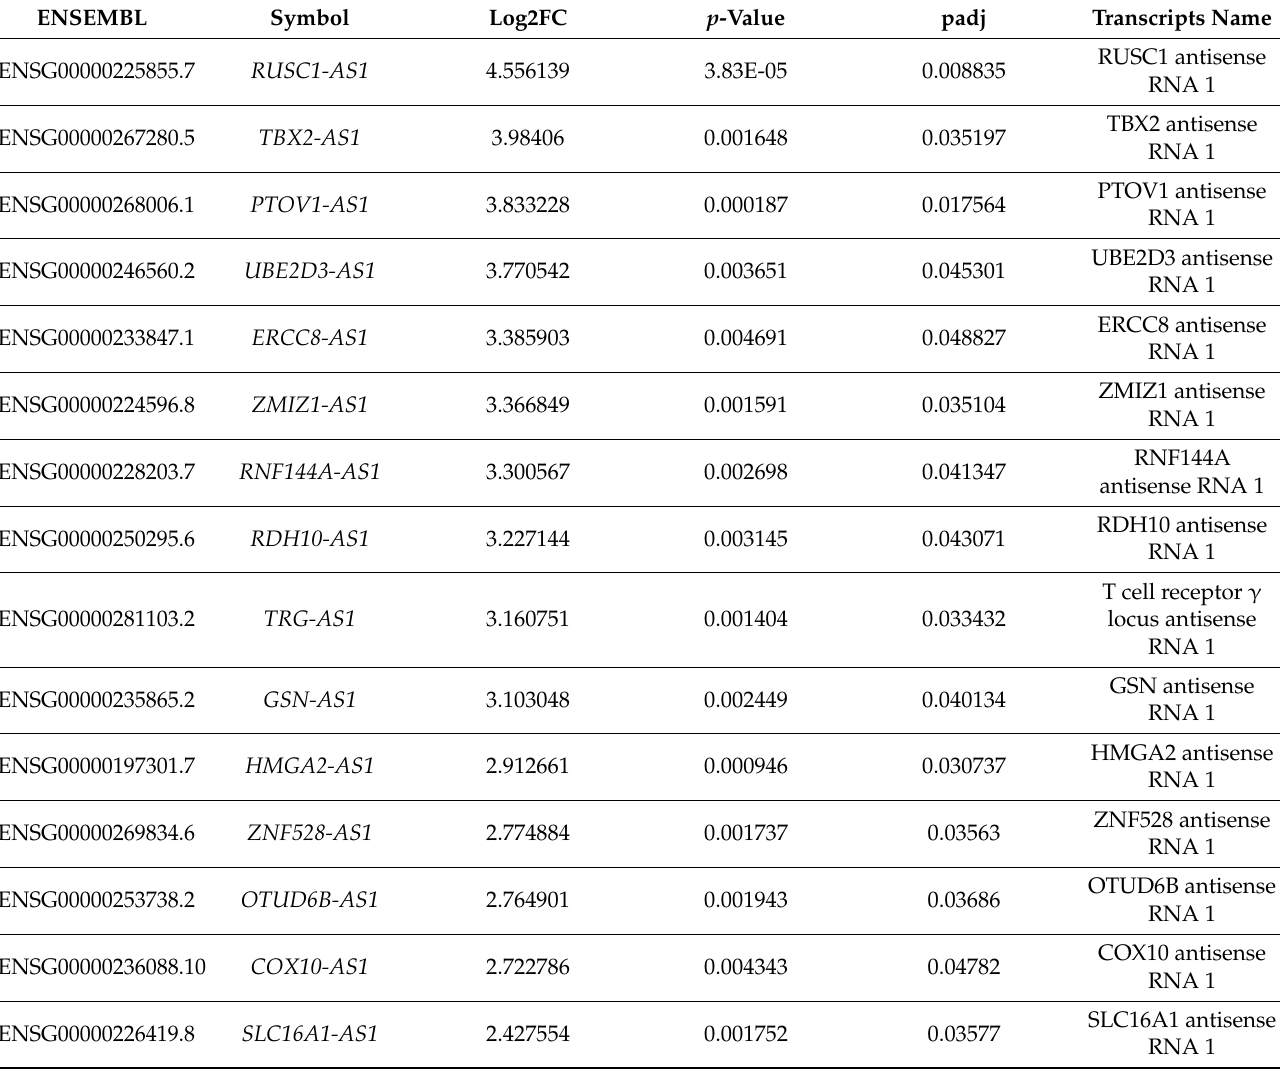
Table 3. The list of differentially expressed antisense lncRNAs transcripts with their corresponding log change values (log2FoldChange), p -value and padj (adjusted- p -value). ENSEMBL Symbol Log2FC p -Value